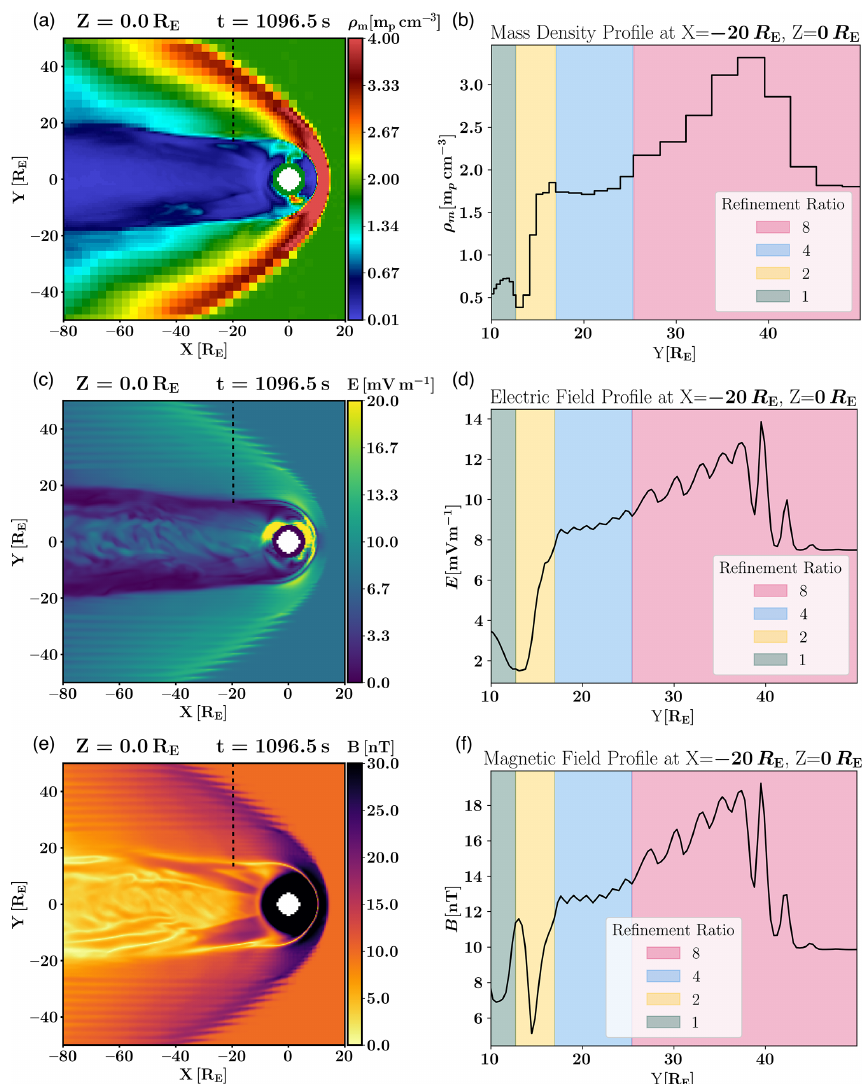
Figure 3. Visualization of a 6D Vlasiator simulation with heterologous grids. (a) Equatorial color map of mass density (on the AMR Vlasov grid). (b) Mass density along the profile shown as a dashed line in panel (a) . In panels (a) and (b) , m p stands for proton mass. (c) Electric field magnitude color map (on the uniform FsGrid). (d) Electric field magnitude along the profile shown as a dashed line in panel (c) . (e) Magnetic field magnitude color map (on the uniform FsGrid). (f) Magnetic field magnitude along the profile shown as a dashed line in panel (e) . The colored regions in panels (b) , (d) , and (f) correspond to the resolution ratio between the field solver grid and the Vlasov grid. Unphysical oscillations in the field quantities, triggered by discontinuities in the moments, can be observed in the green and red